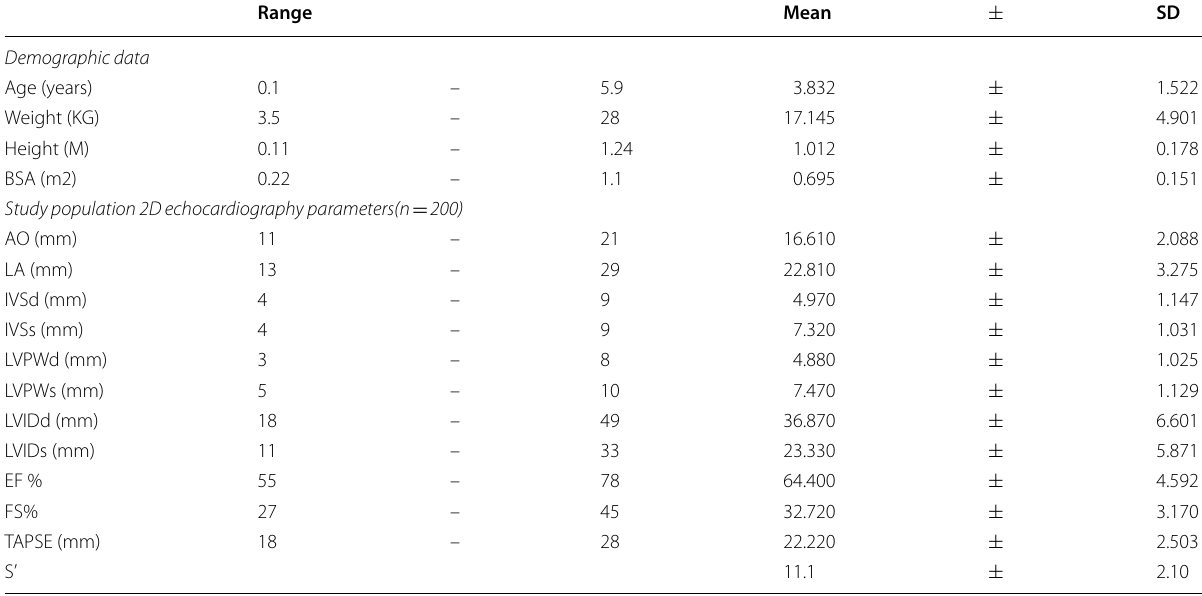
AO aortic root, LA left atrium, BSA body surface area, IVSd interventricular septum in diastole, IVSs interventricular septum in systole, LVPWd left ventricular posterior wall in diastole, LVPWs left ventricular posterior wall in systole, LVIDd left ventricular internal dimension in diastole, LVIDs left ventricular internal dimension in systole, EF ejection fraction, FS fractional shortening, S ’ myocardial velocity during systole, TASPSE tricuspid annulus plane systolic excursion Table 2 Mean of 2D speckle tracking echocardiography (STE) parameter in subjects of our study categorized according to age-group and r and P values of correlation between 2D strain and age